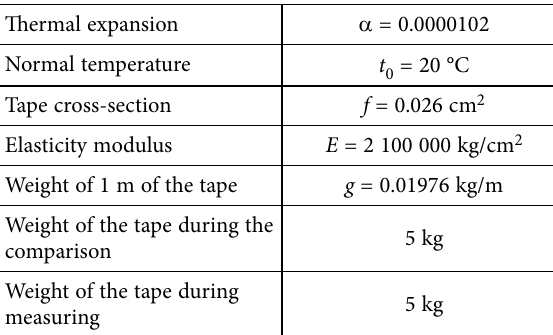
Fig. 1. The temperature in ČSA 2 shaft